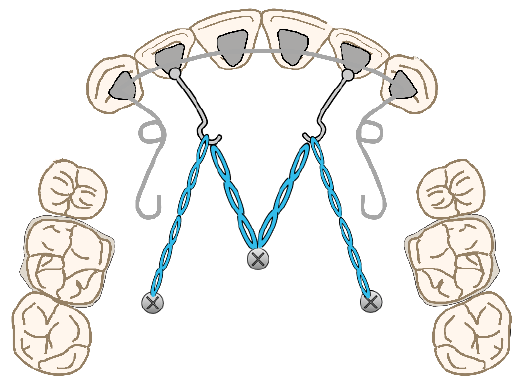
Figure 4. Schematic representation of the Double J retractor (DJR) in which the torquing spring is activated by contacting the mini-implant on the palatal slope. Redrawn with permission from Am J Orthod Dentofacial Orthop [23].